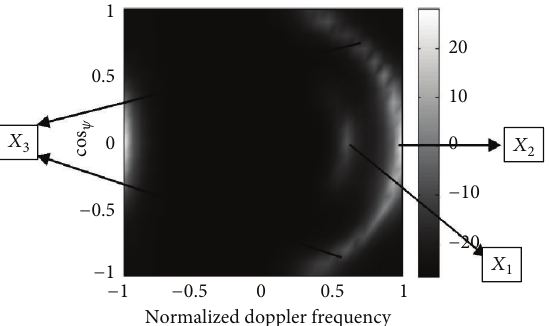
Figure 2: Clutter spectrum distribution of forward-looking planar array in azimuth-Doppler plane.